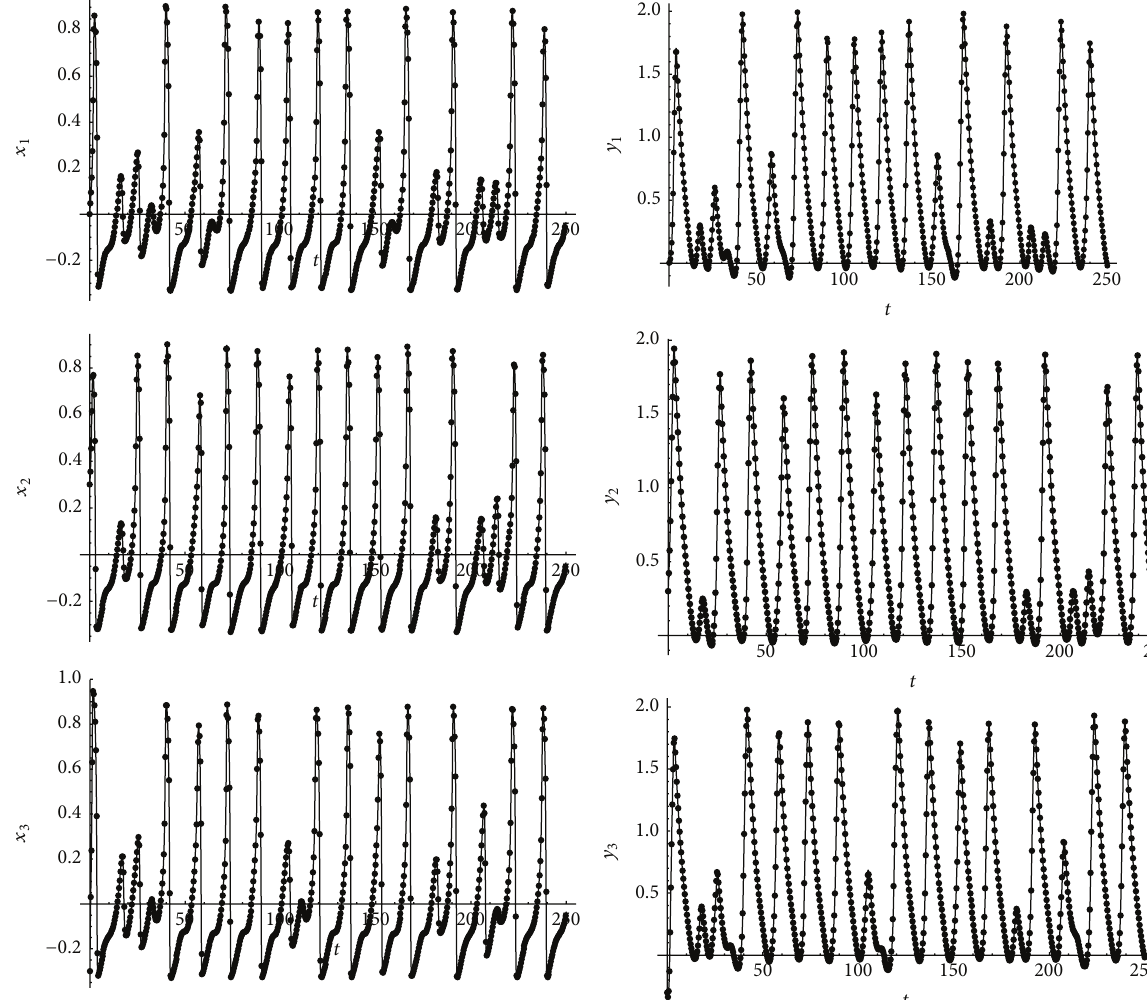
Figure 1: Numerical solutions of the FHN system; MSGDTM: dotted line; RK4: solid line, with 𝛼 1 = 𝛼 2 = 𝛼 3 = 𝛼 4 = 𝛼 5 = 𝛼 6 = 1 .